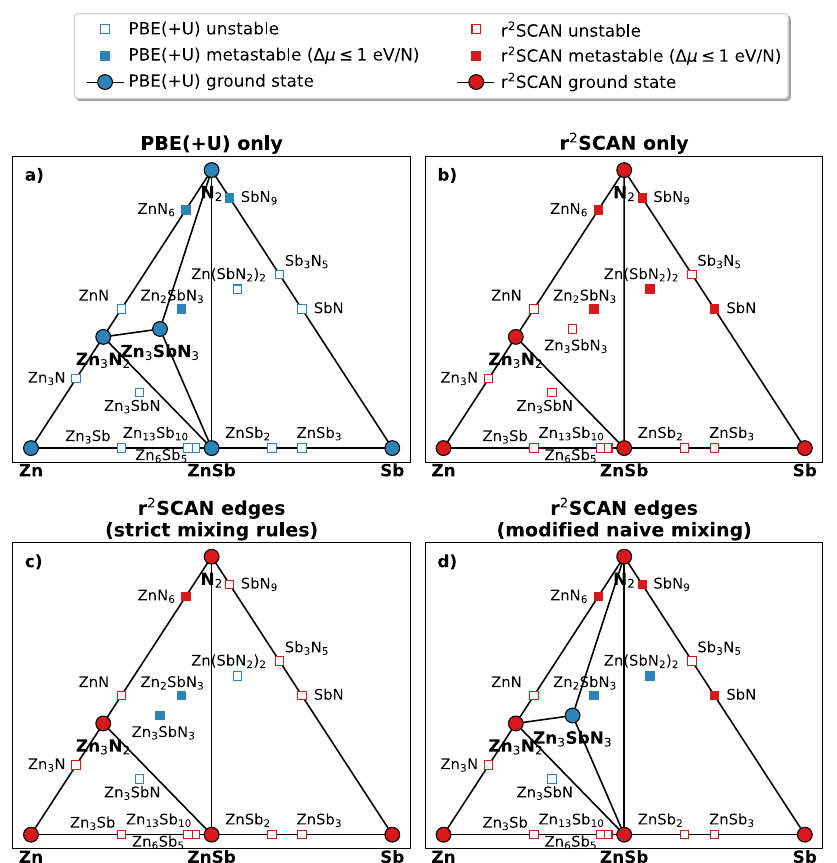
Fig. 4 Zn – Sb – N phase diagrams illustrating different mixing strategies for PBE( + U ) and r 2 SCAN calculations. a PBE( + U ) only; b r 2 SCAN only; c strict application of Rule #1 and #2 to calculations comprising r 2 SCAN energies for all elements and binary phases with PBE( + U ) energies for all ternary phases ( d ) same set of calculations as ( c ), but using modi fi ed naive mixing in which binary hulls are constructed from r 2 SCAN formation energies. Phases labeled `metastable' are phases that can be stabilized by a + 1 eV perN increase in the nitrogen chemical potential, which is achievable in laboratory synthesis 30,42,43 . Tabulated r 2 SCAN and PBE( + U ) energies for all materials are available as Supplementary Data (see Supplementary Note